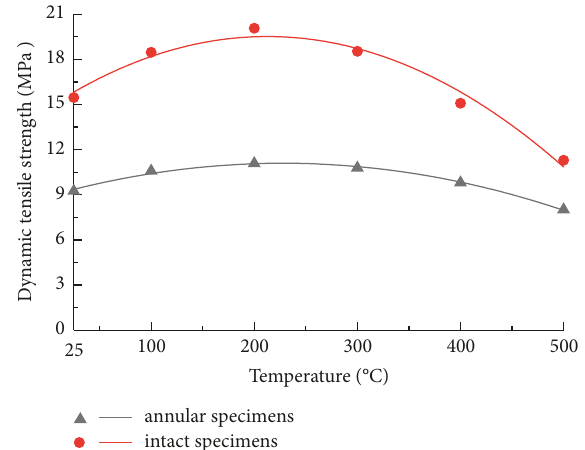
Figure 11: Dynamic peak strain of samples after different temperatures.